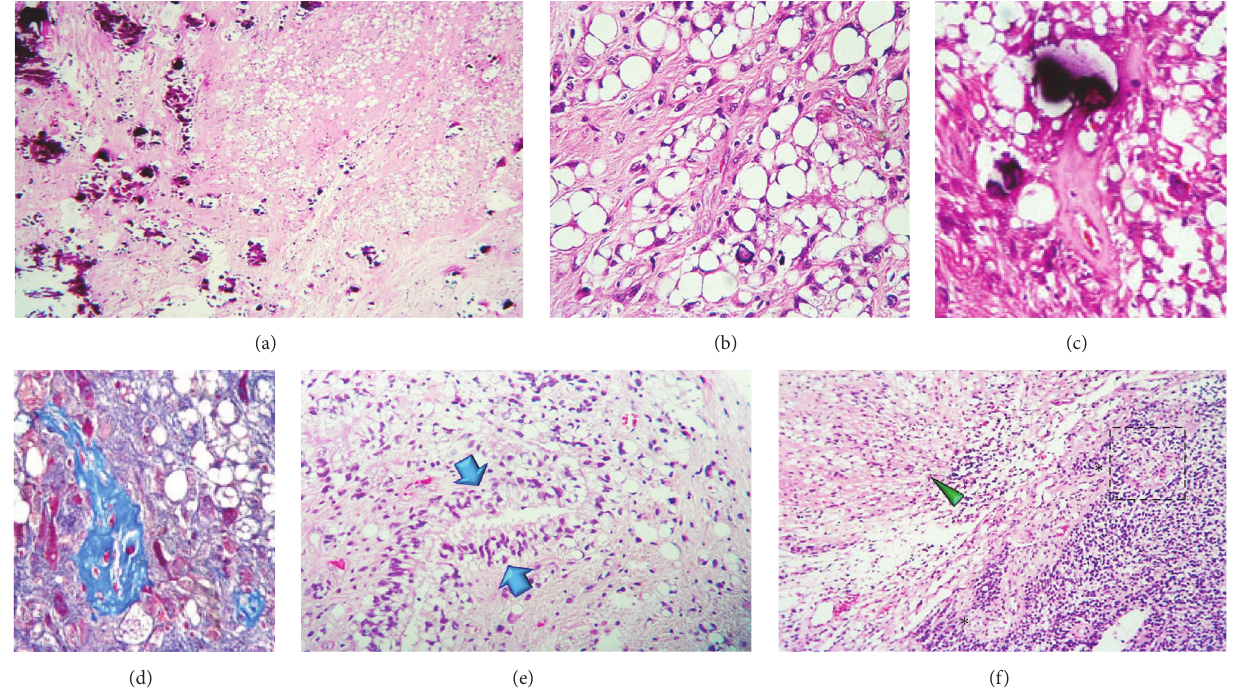
Figure 2: Histopathological findings (lipomatous/vacuolated component). (a) Low magnification photomicrograph showing numerous dystrophic calcification foci (left field) around areas resembling fat lobules (right upper field). (b) Signet-ring cells with an optically empty cytoplasm resembling adipose tissue. (c) Heavily hyalinised vessel with dystrophic calcification in a high-power field. (d) Densely collagenised vessel seen with Masson’s trichrome in a high-power field. (e) Fortuitously found ependymal channel (blue arrows). This one attests partial vacuolation of the ependymal lining. (f) Boundary zone between a signet-ring cell area (green arrowhead) and the anaplastic component (right field). The black asterisks plot a long tailed blood vessel which ends in a microvascular proliferated glomerulus-like